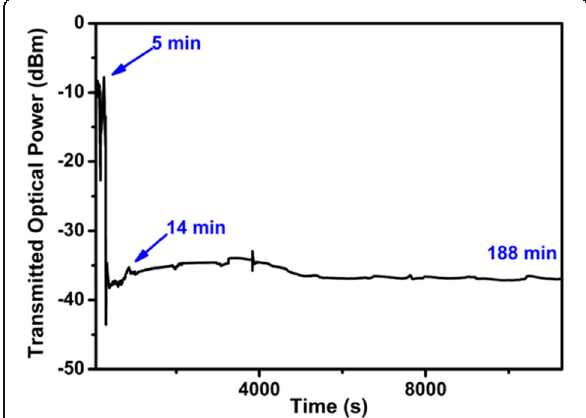
Fig. 3 Variation of TOP in MF during the deposition of WSe 2